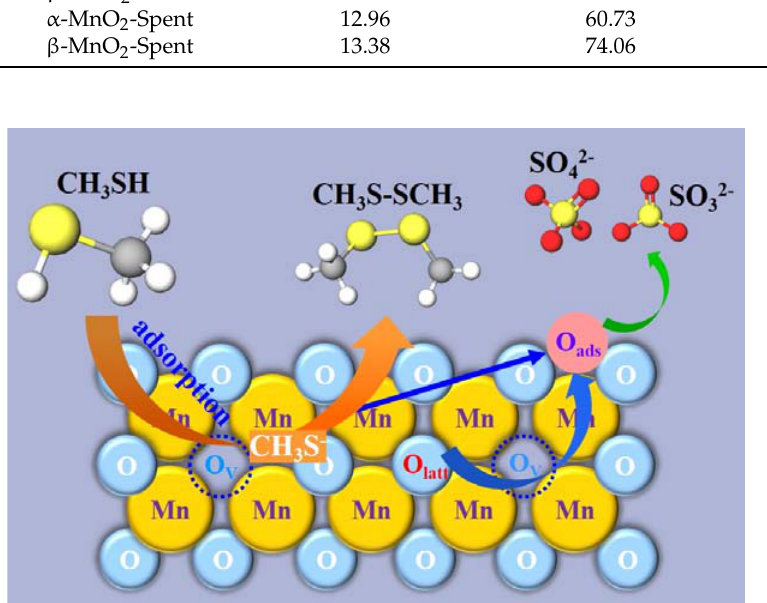
Figure 14. Reaction mechanism of CH 3 SH decomposition over MnO 2 catalysts.